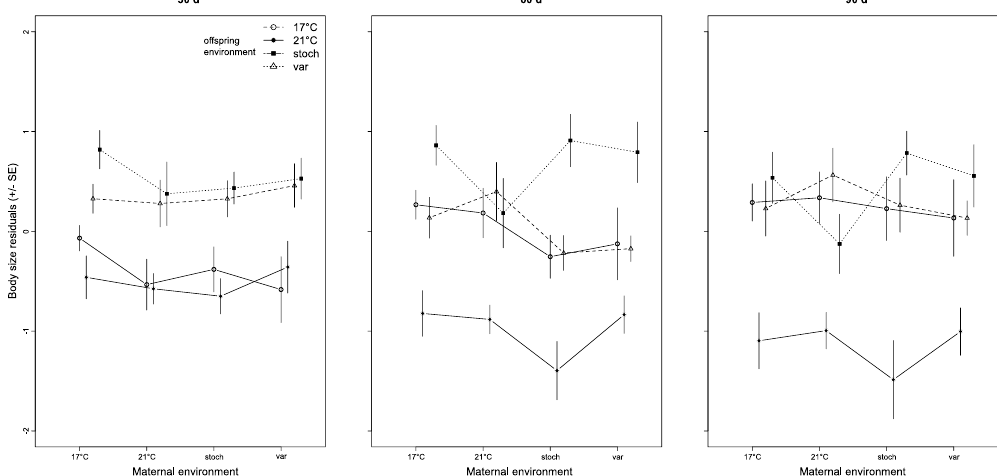
Figure 2. Body size residuals (standard length (mm) corrected for density) of stickleback ( Gasterosteus aculeatus ) offspring at 30, 60 and 90d post-hatch in the four maternal acclimation and offspring rearing temperature environments (constant 17 °C; open circles, constant 21 C; closed circles, predictably variable; open triangles, and stochastically variable; closed squares). Points reflect means ( ± SE) of all families within each maternal-offspring temperature combination; lines join offspring rearing